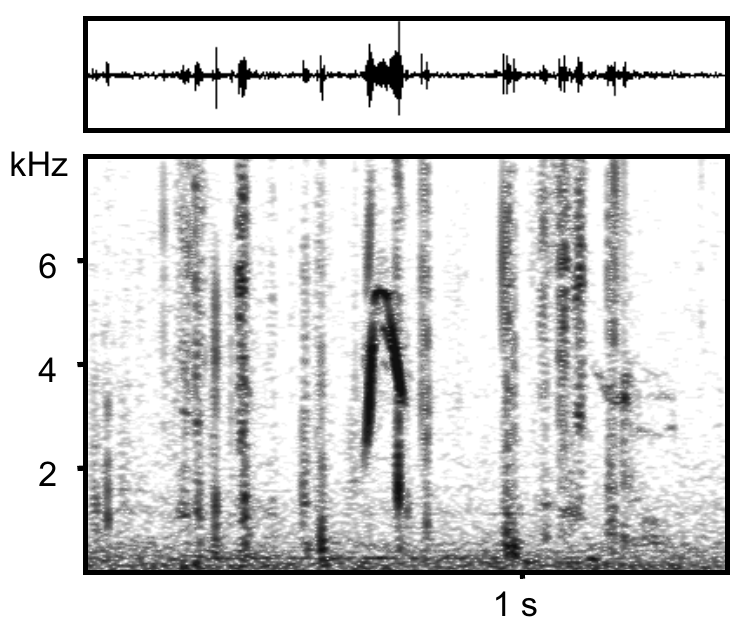
Fig. 1 – Contact call of an Arabian Babbler. Subjects commonly utter such calls during foraging. Note that the call is masked by noise (vertical lines) caused by subjects pecking on the ground.